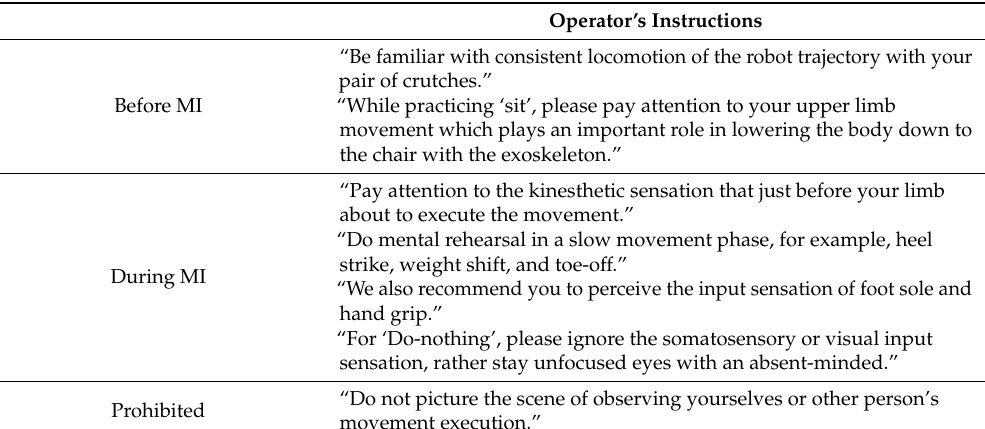
Table 1. Detail of motor imagery (MI)